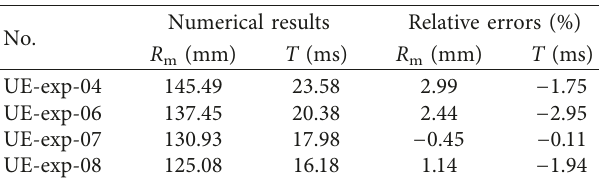
Figure 20: The curve of experiment and numerical bubble radius varying with time. Table 11: Comparison of test and numerical results of R m and T under various gravity